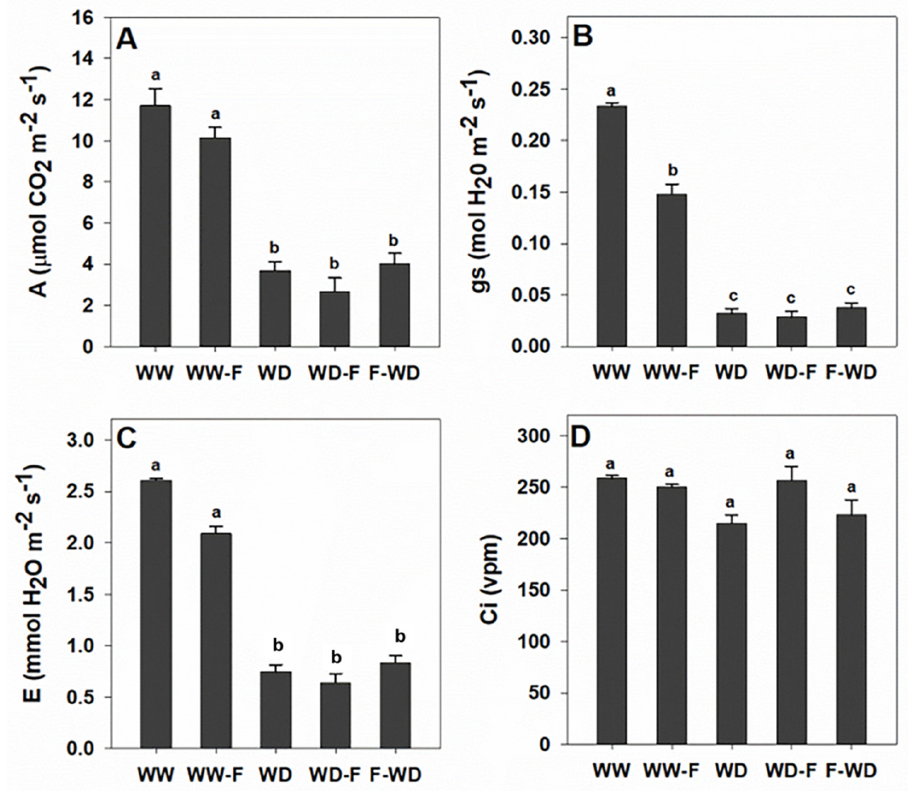
Figure 3. ( A ) Net photosynthetic rate (A), ( B ) stomatal conductance (gs), ( C ) transpiration rate (E), and ( D ) internal CO2 concentration (Ci) of grapevine plants exposed to WW (well-watered control); WW-F (well-watered fungal inoculation); WD (water deficit); F-WD (inoculation before water deficit); WD-F (inoculation after water deficit). Different lowercase letters indicate significant differences among the five treated groups ( p ≤ 0.05).